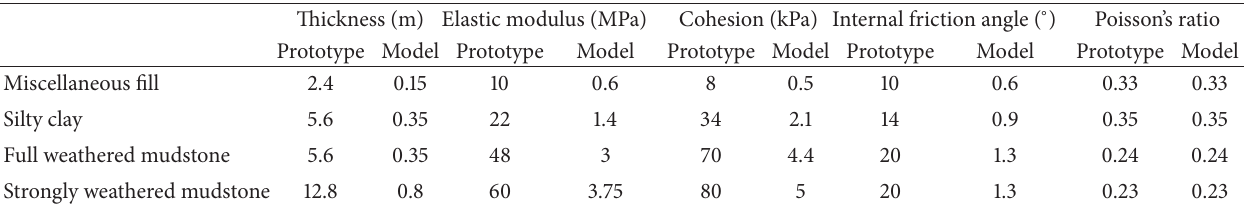
Table 2: Physical and mechanical parameters of prototype materials and model